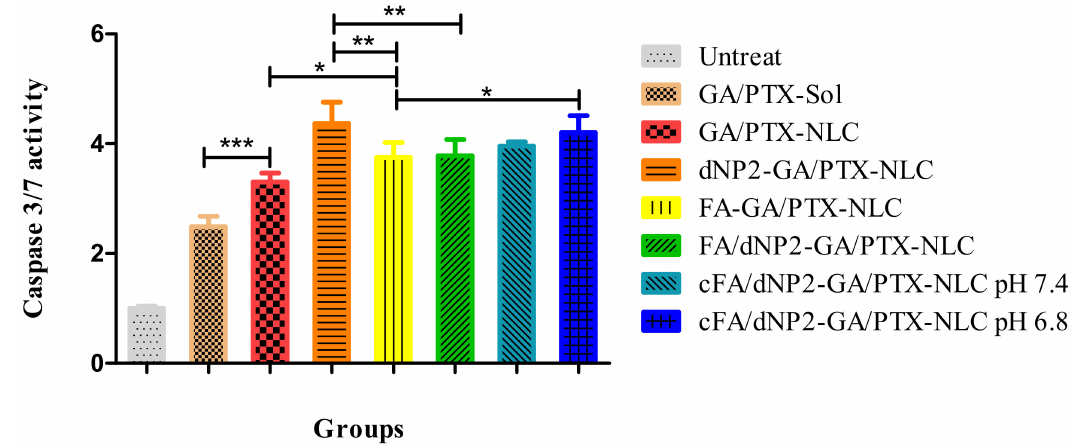
Figure 8. Caspase 3/7 activity in 4T1 cells treated by different formulations. Results are expressed as mean ± SD, n = 3. * p < 0.05; ** p < 0.01; *** p < 0.001.